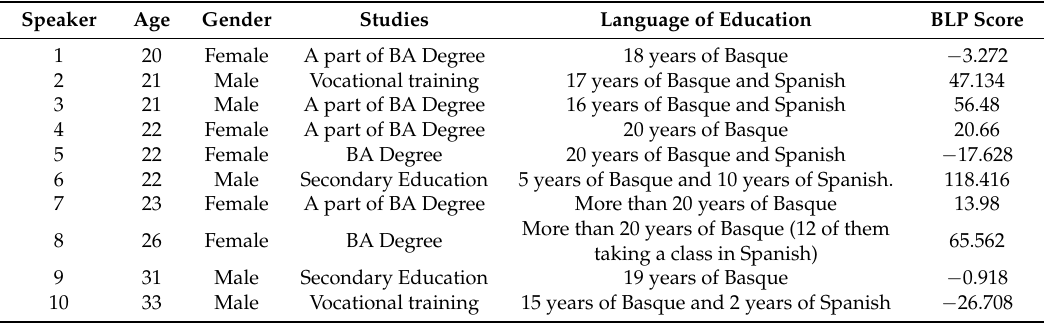
Table 2. Age, gender, studies, language of education, and Bilingual Language Profile (BLP) scores of the participants in the current